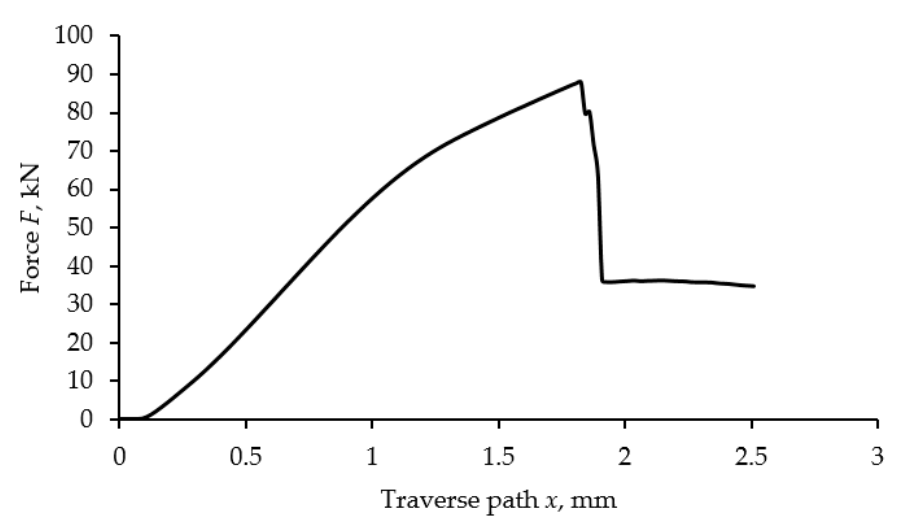
Figure 9. Force-displacement diagram of a push-out tests on a sample sectioned from the front end of a compound profile produced with an extrusion ratio of 11:1.